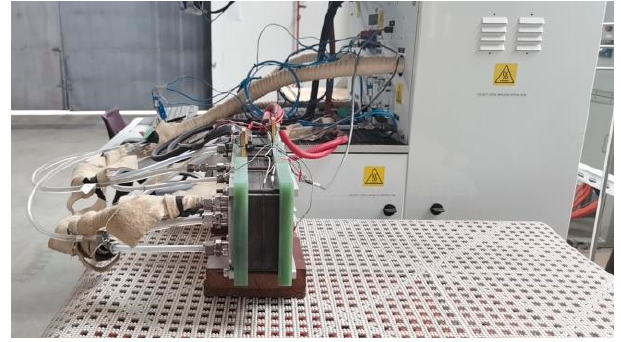
Figure 3. PEMFC experiment bench.